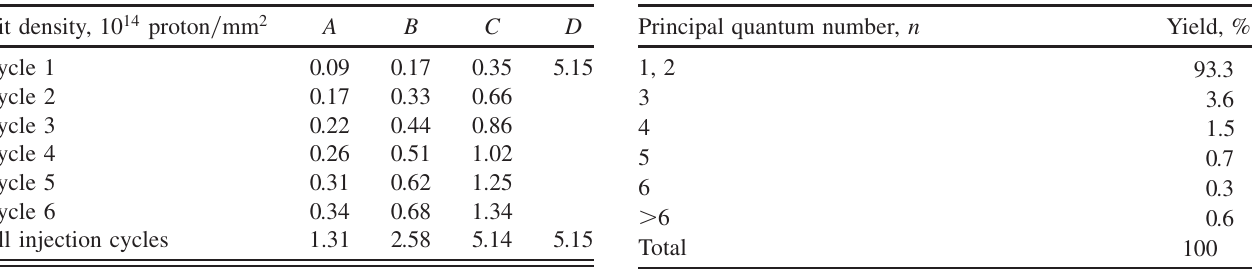
TABLE VI. Experimental data on fractional yields of excited states of H 0 atoms due to foil stripping for incident 0.8-GeV H (cid:1) ions.